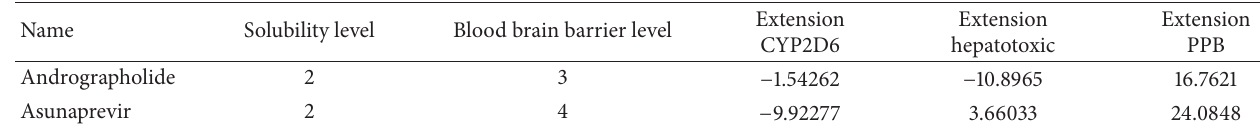
Table 2: Comparison of the ADME values of